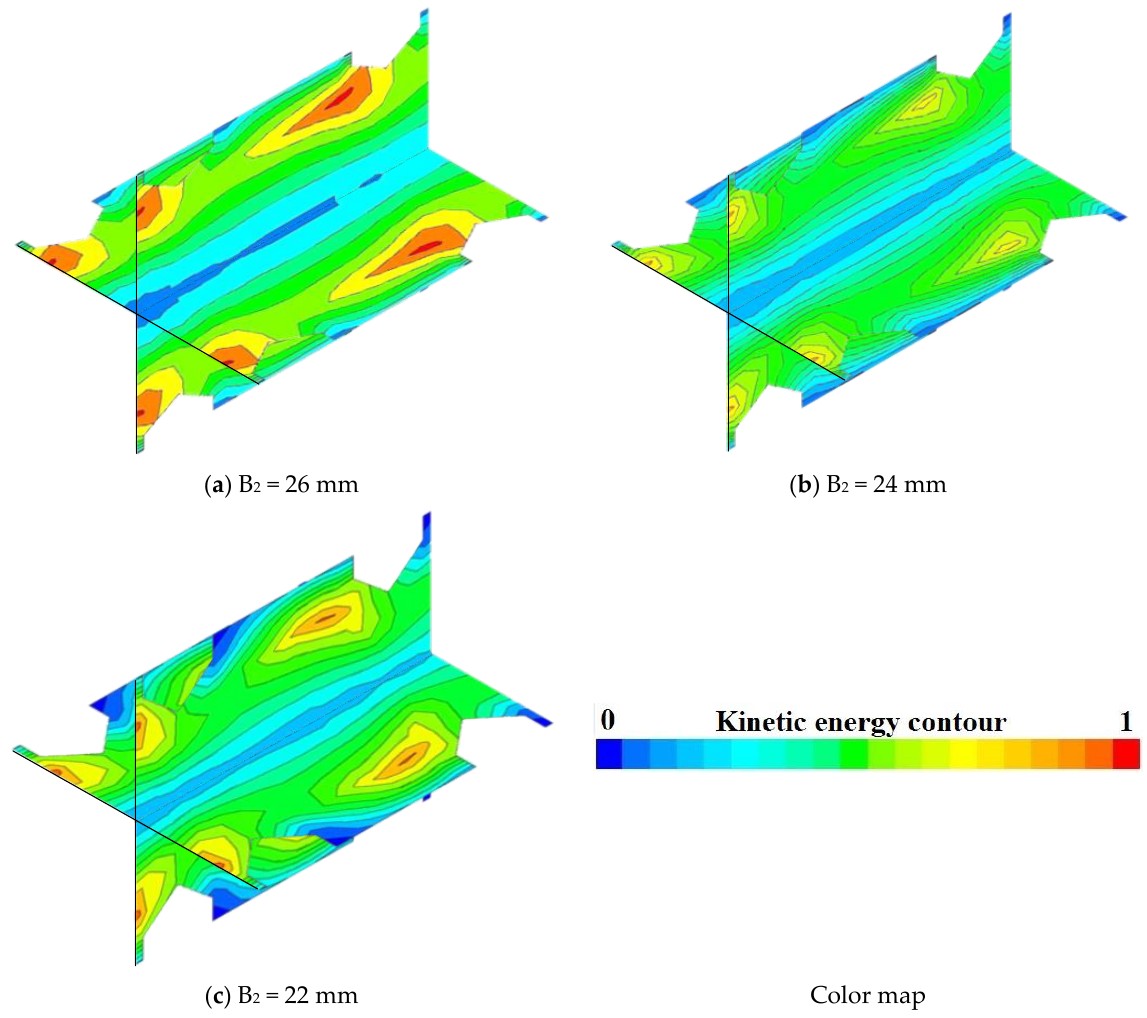
Figure 18. Kinetic energy contours for various configurations of Case B with different B 2 parameters at R = 15 mm, Re = 15,000, and 𝜑 = 0.5%.